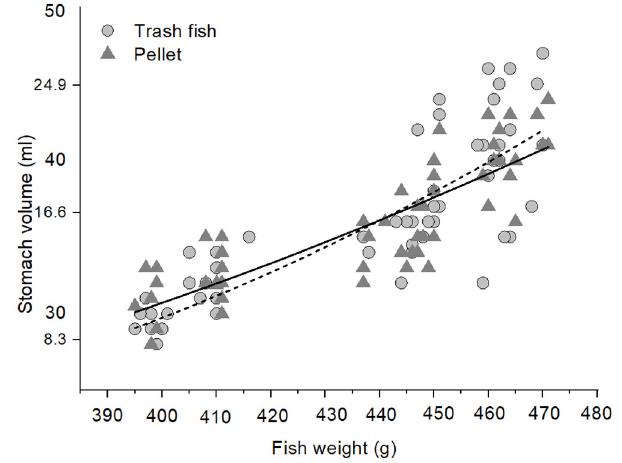
Figure 3. Relationship between stomach volume (mL) and fish weight (g, wet weight) of the adult hybrid Sabah grouper fed, fitted with the allometric model both in pellet and trash fish diets. For the pellet diet, the equation of stomach volume was 0.001 W 1.724 (chi ‐ square = 4.698; r 2 = 0.72). Meanwhile, for the trash fish diet, the equation of stomach volume was 0.0002 W 2.12 (chi ‐ square = 3.424; r 2 = 0.84).